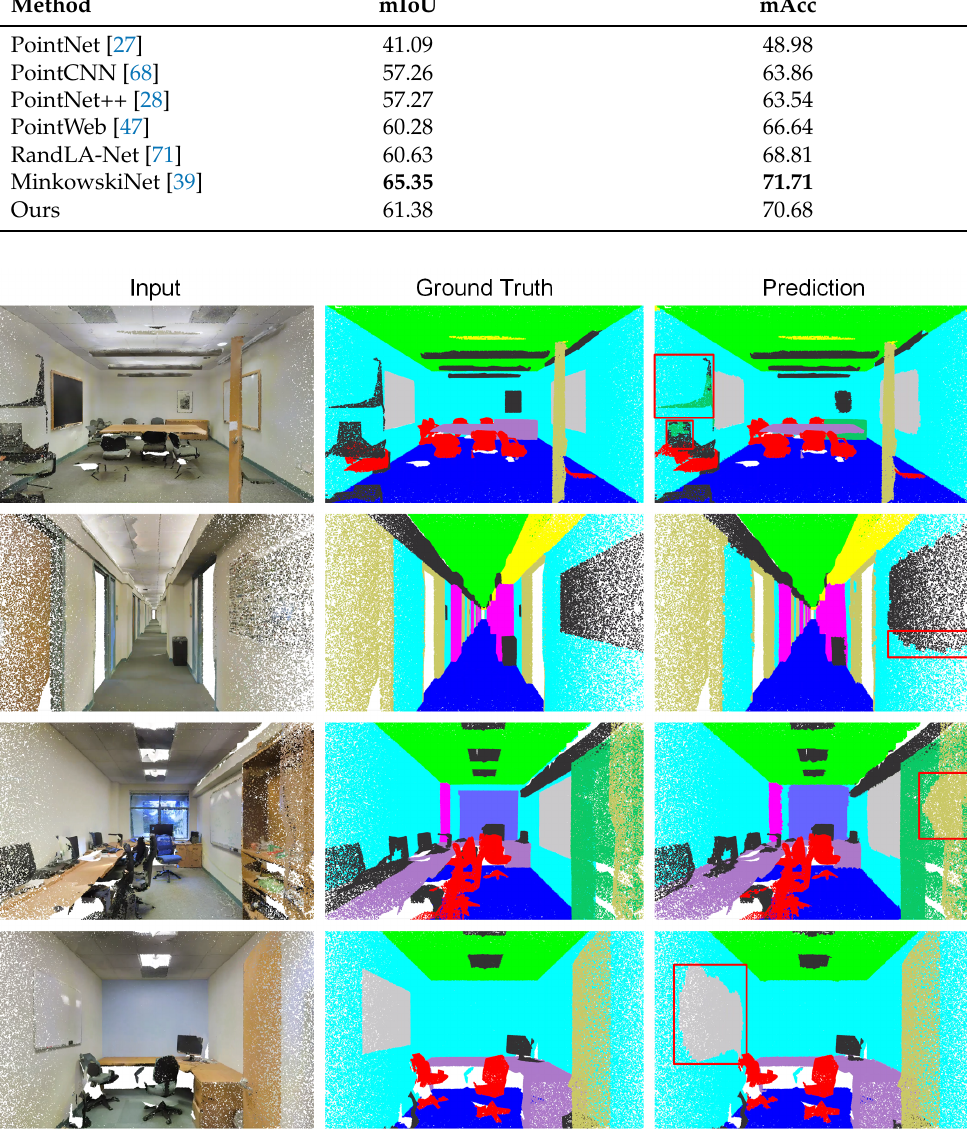
Figure 9. Qualitative results for the semantic segmentation task on S3DIS. Regions with large deviations between the predicted results and the ground truths are marked with red